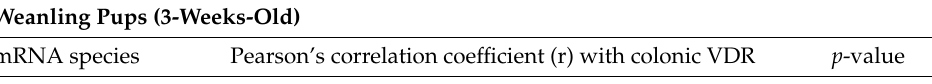
Table 1. Pearson’s correlations between mRNA expression of VDR and proinflammatory markers in weanling and adult offspring colon